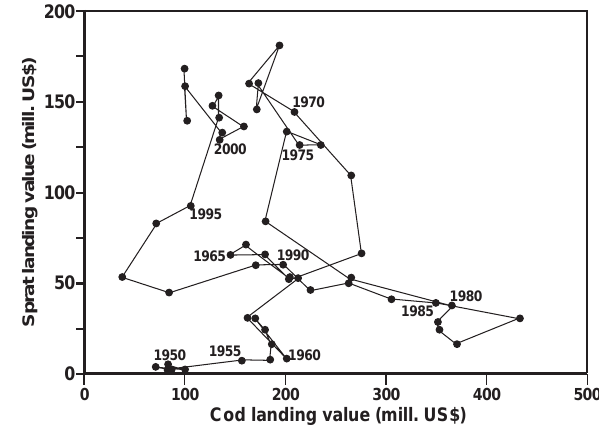
Fig. 7. Correlation between landing values of cod and sprat in the Baltic Sea from 1950 to 2004. Catches of sprat and cod substitute to a certain degree. Landing values of cod are rather stable for the pe- riod of 1955 to 1979. A short period of intensified fisheries ends in 1985 with a sharp decline in cod landing value to below the former revenue and remaining low until the present. The decline in landing value coincides with the lack of fresh North Sea water inflow. (Data from